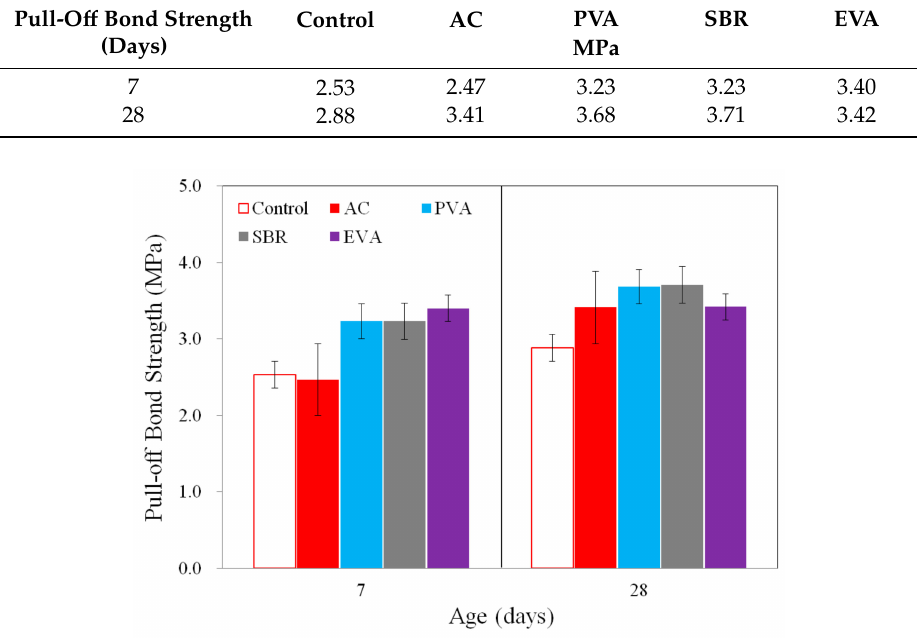
Figure 5. Pull-o ff bond strengths for the PCMs and control mortar measured at seven and 28 days.